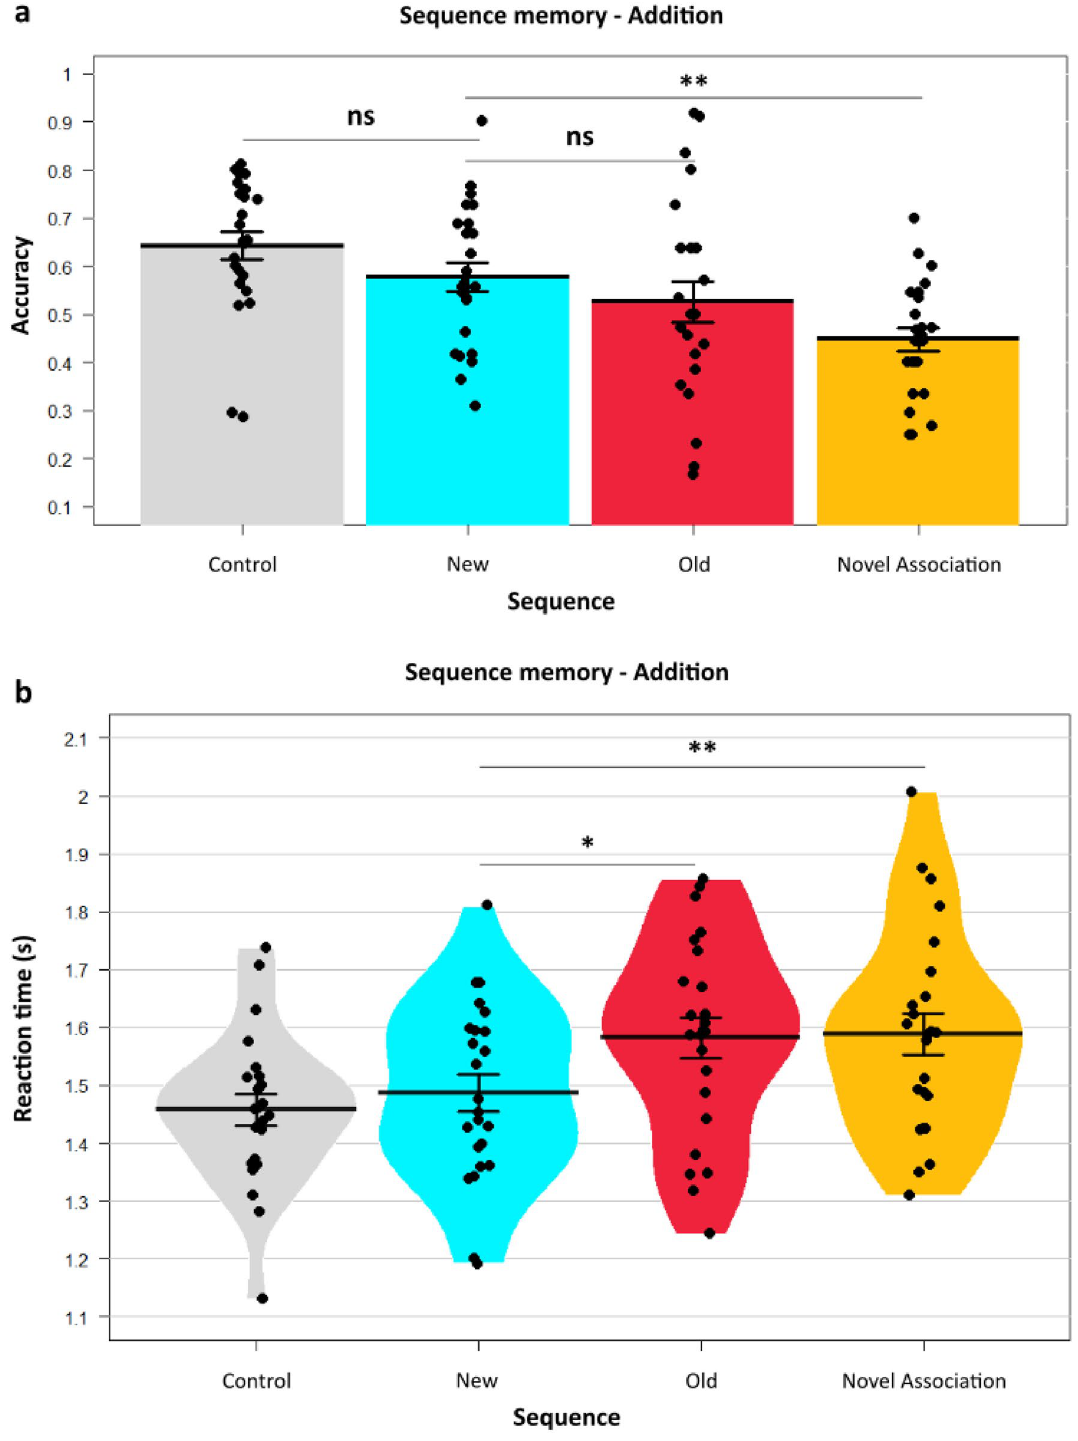
Figure 3. Prediction errors affect temporal memories even with reactivation. The Addition condition had New sequence formation similar to Substitution by a contextual prediction error . Unlike the Substitution the Old segment was re-experienced again in this condition. ( a ) Memory accuracy performance shows no significant difference between New and Old sequence for temporal order judgment after re-experiencing the older memory sequences. No significant difference in accuracy between New and Control sequences was observed. ( b ) Reaction time data displaying significant difference between New and Old sequence, even after re-experiencing the latter sequences. Dots represent participants’ individual performance ( n = 24). Error bars denote